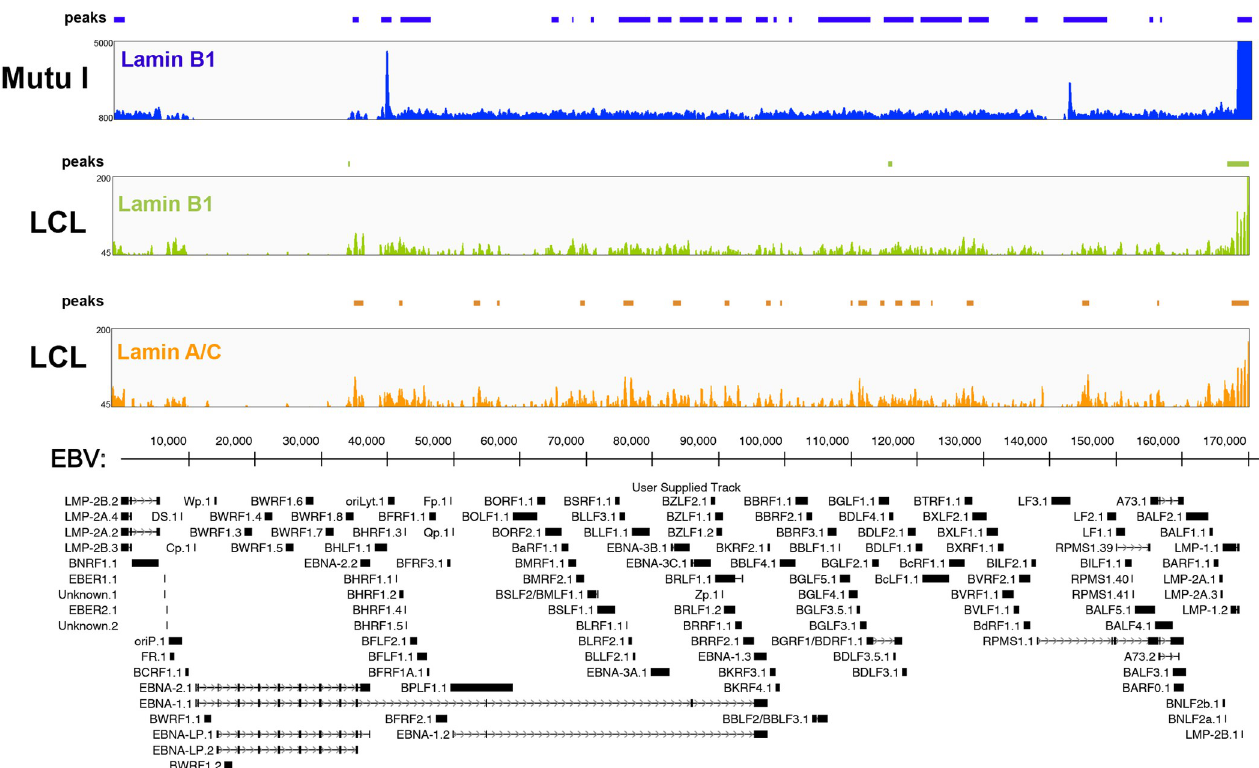
Fig 4. The EBV genome interacts with the nuclear lamins. A) ChIP-Seq analysis of lamin B1 and lamin A/C binding in EBV+ B cells adopting Type I (Mutu I) or Type III (LCLs) latency. Blue track profile: lamin B1 binding in type I cells; green track profile: lamin B1 binding in type III cells; orange track profile: lamin A/C binding in type III cells. The peaks identified through peak calling method are indicated above each track. Tracks are aligned with the annotated EBV genome shown at the